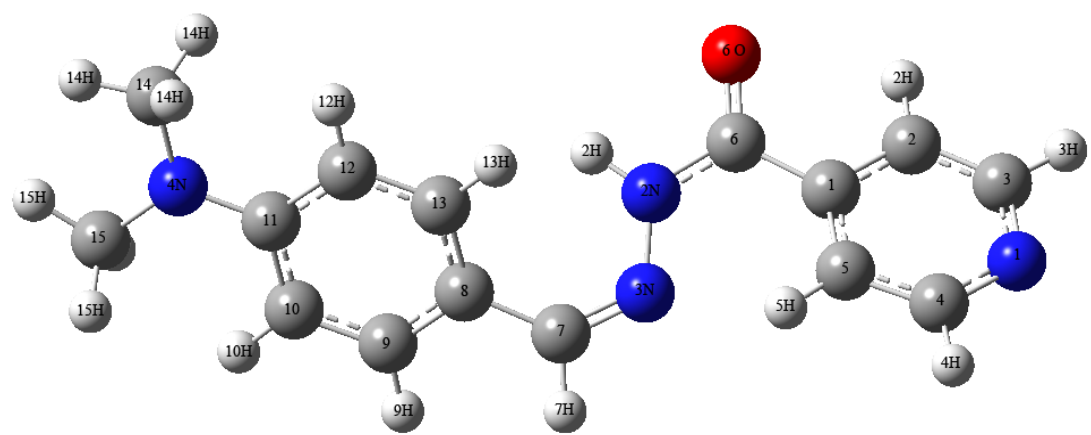
Figure 2. Numbering system adopted in the study for 1 using B3LYP/6-311G**.